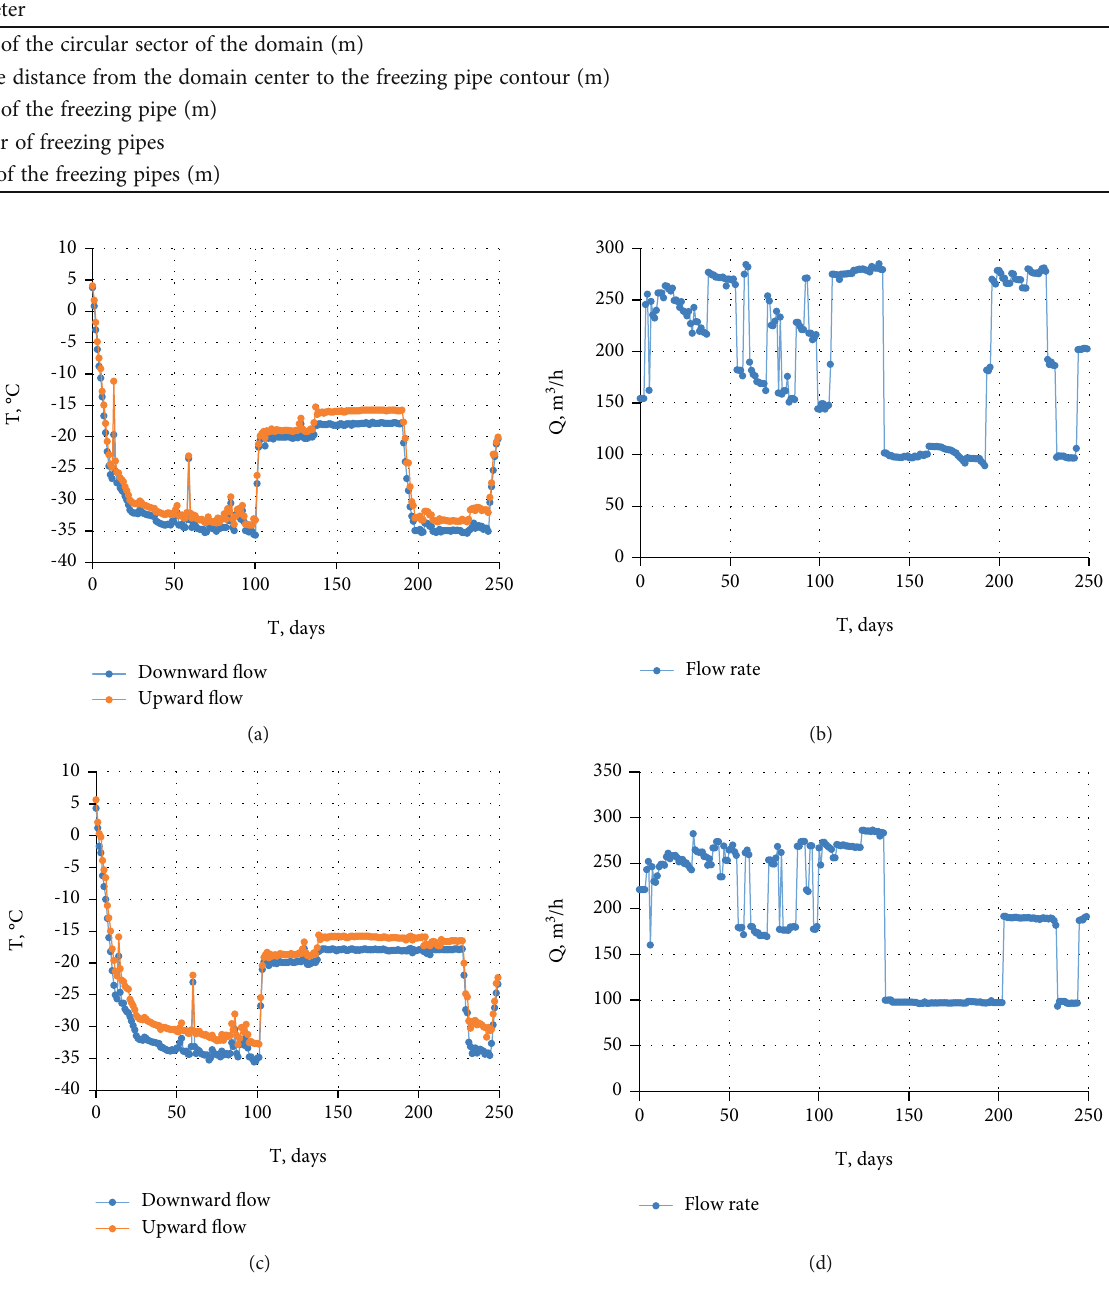
Figure 3: Time charts of the coolant temperature and fl ow rate in the freezing systems for shafts no. 1 (a, b) and no. 2 (c,